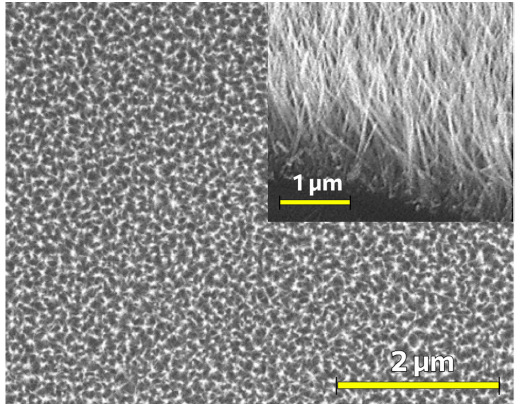
Figure 4. SEM micrograph of a coating of ZnO nanorods formed by a low-temperature hydrother- mal method with suppression of nucleation in the bulk solution and the use of a seed layer formed by ultrasonic spray pyrolysis. The inset shows the cross-section of the